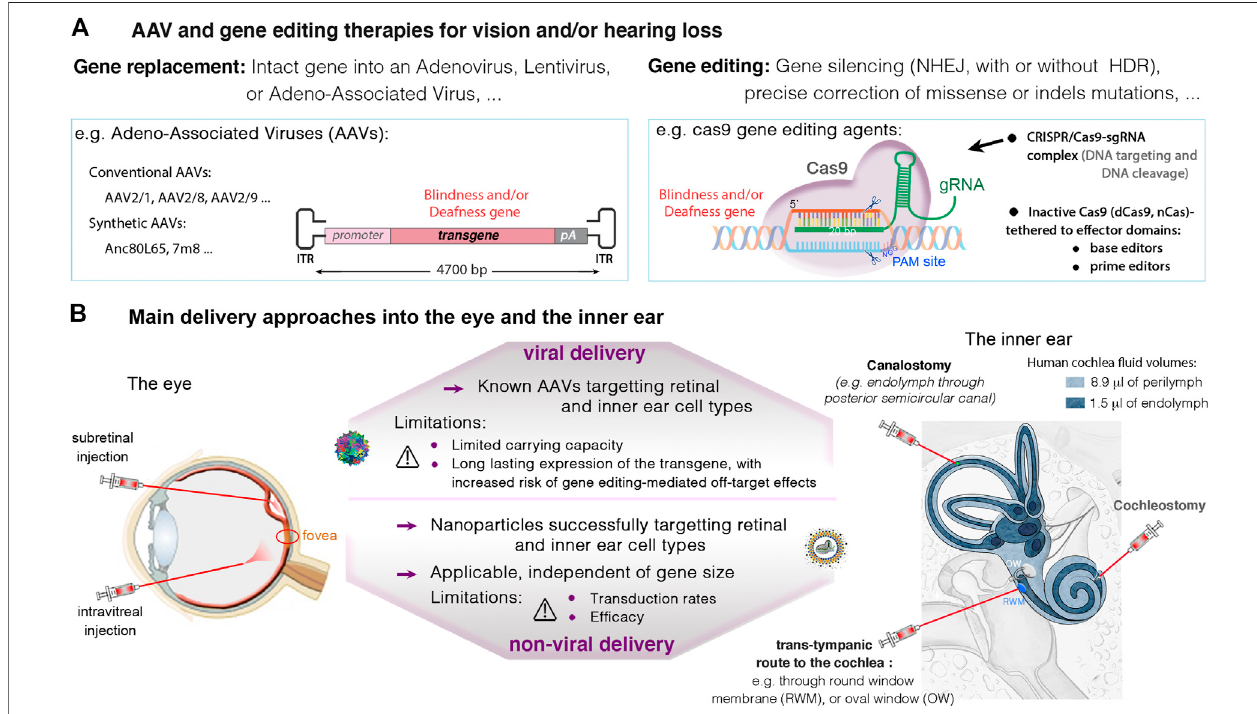
FIGURE 4| (A) Viral and non-viraldelivery, and gene editing therapies in the eye and the inner ear. (A) Current therapeutic strategies with promising success in the eyeandtheinnerearinvolve genereplacementusingadeno-associatedviruses(AAVs),andgeneeditingtargetingspeci fi cmutationscausingvisionand/or hearingloss. (B) Animportantchallengeineyeandeartherapeuticsistherouteofadministration.Intheretina,thesubretinalinjectionmaybefavoredtoensurehightransductionrates of photoreceptor and RPE cells. The intravitreal route is recommended for targeting the ganglion and inner nuclear cell layers, and particularly, the central retina. In the inner ear, main administration routes include local injections into the perilymph through the round-window membrane (RWM), or through the oval-window (trans- stapedial injection). Injections into the endolymph, in the cochlear scala media (cochleostomy) or through a semicircular canal (canalostomy), remain challenging, with high risk of sensory damage. Thanks to smaller size cas9 enzymes, it ’ s possible to use AAVs to transfer the CRISPR-Cas9/gRNA complex into target cells. Alternatives exist for larger nucleases such as base or prime editors, which include the use of dual AAVs, or non-viral vectors (e.g., liposomes), which additionally can be used for delivering Cas protein instead of